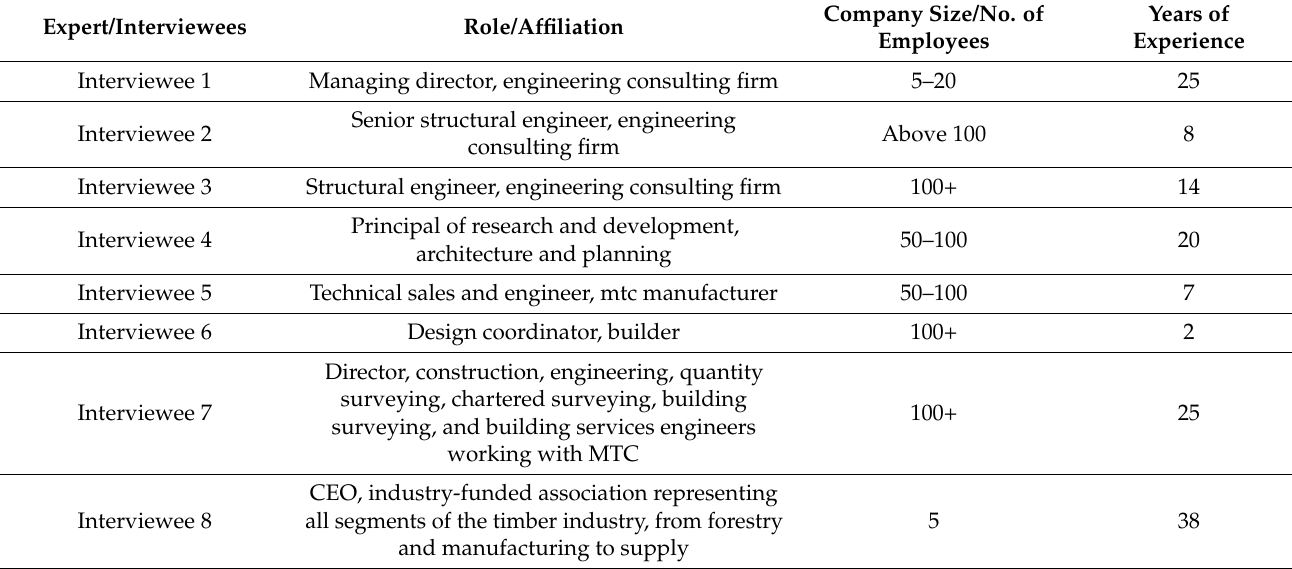
Table 3. Background of the